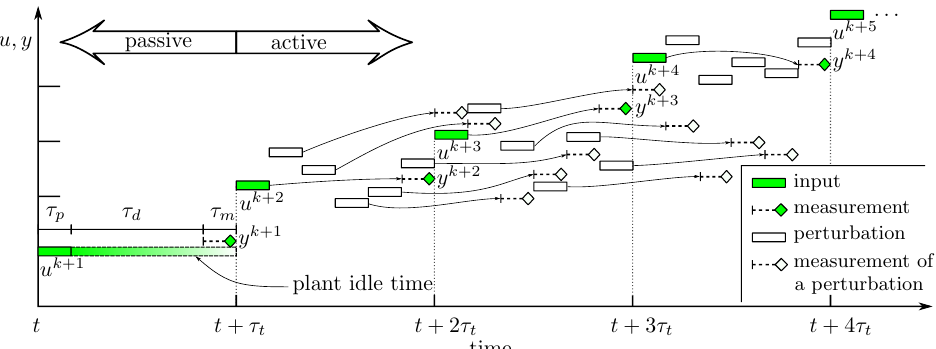
Figure 2. Illustration of standard modifier adaptation method and of active perturbation method.